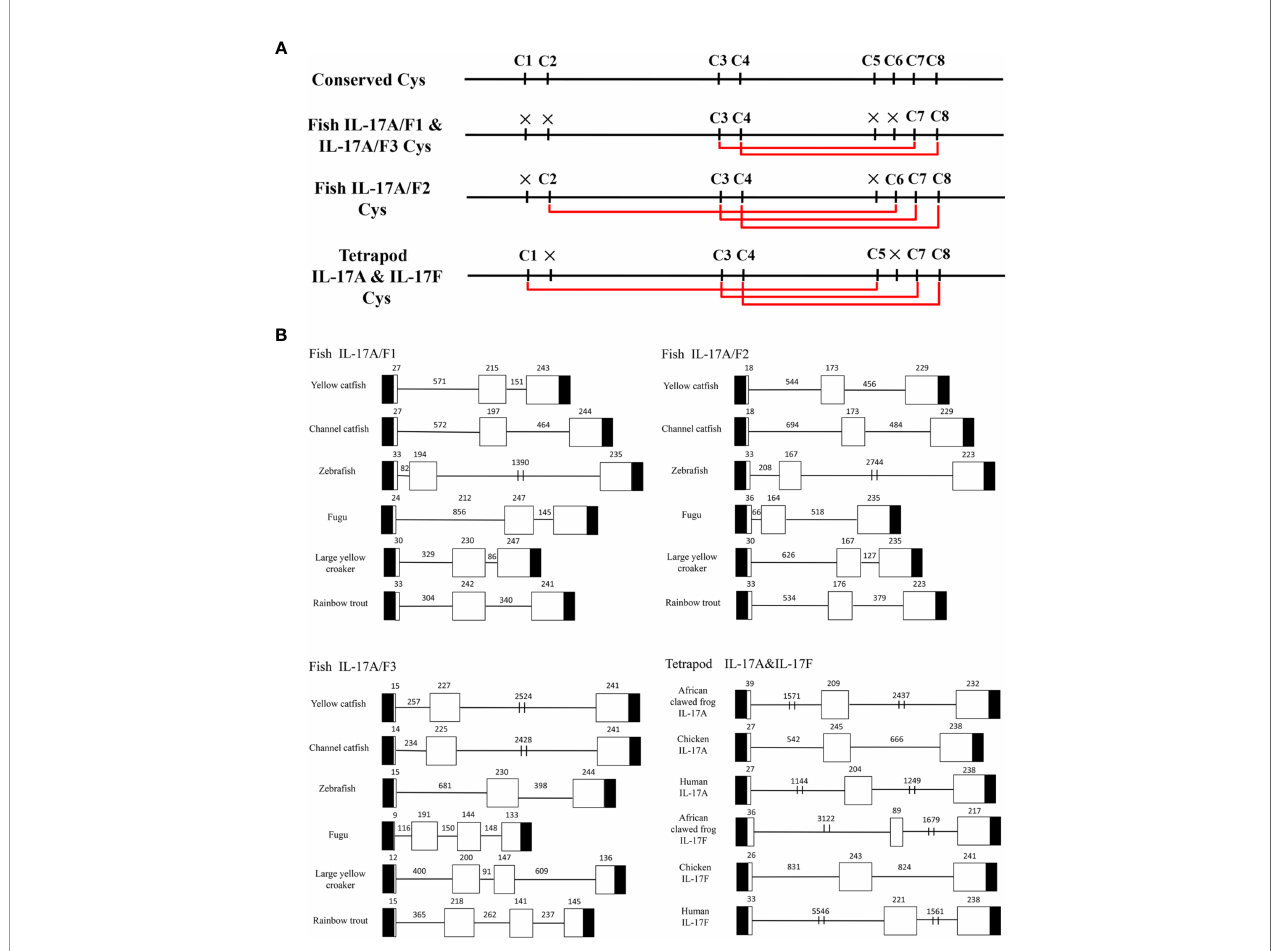
FIGURE 1 | Conserved cysteine residues and predicted potential intra-molecular disul fi de bonds in the deduced amino acid sequences of fi sh IL-17A/F1, 2 and 3 genes and tetrapod IL-17A and F genes (A) and comparison of the gene organization of these genes (B) . (A) Cysteine residues potentially forming disul fi de bonds are linked by red lines in tetrapod IL-17A and F, and fi sh IL-17A/F1, 2 and 3. The disul fi de bonds were predicted using DISULFIND. (B) The black boxes represent untranslated region, the white boxes represent exons, and the lines represent introns. The genomic sequences are taken from the NCBI database: Yellow cat fi